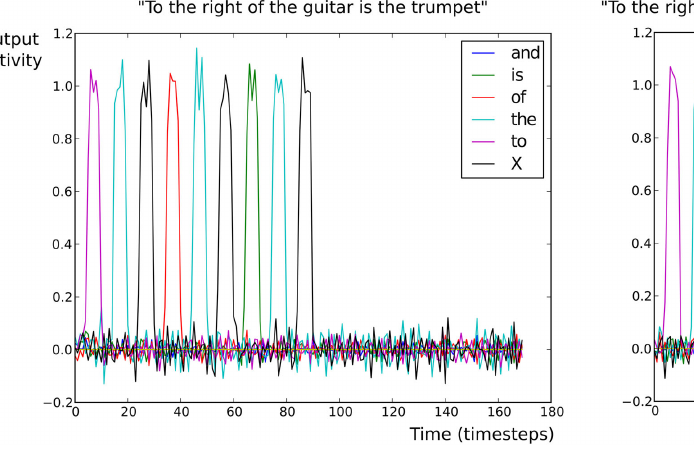
FIGURE 9 | Output (read-out) unit activations of the production neural model in the Scene Description task. Each colored line represents a different read-out neuron. Each read-out neuron corresponds to a different word: either a grammatical word or a SW marker. On the x-axis is indicated the number of time steps. On the y-axis is indicated the neural activity for output neurons. X indicates the semantic word (SW) marker. (Left) The